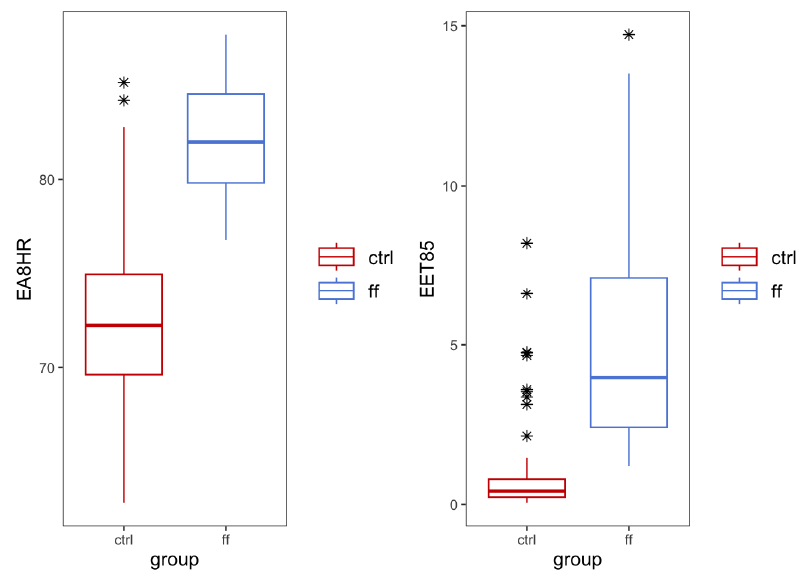
Figure 2. Comparison of EET85 and EA8hr between firefighters and controls. Estimated exposure at 85 dBA (EET85) values was significantly higher for firefighters when compared to controls ( t (71) = 8.8, p < 0.001). Equivalent exposure 8 h (EA8hr) was significantly different between firefighters and controls ( t (71) = 8.8, p < 0.001). * Highlight the